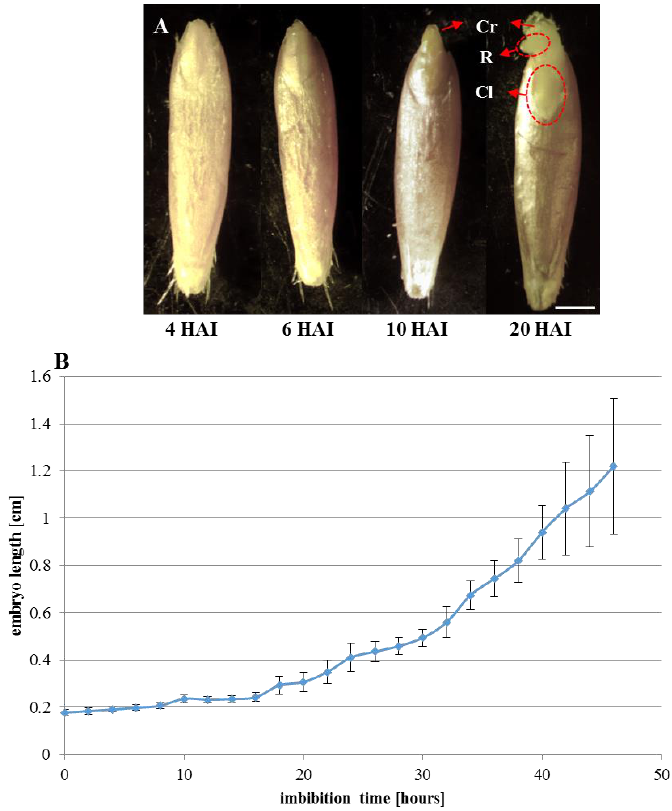
Figure 1. Brachypodium distachyon (Brachypodium) grains at key time points of imbibition ( A ) and the progress of Brachypodium embryo size growth during 46 h of imbibition ( B ), data are means ± SE.